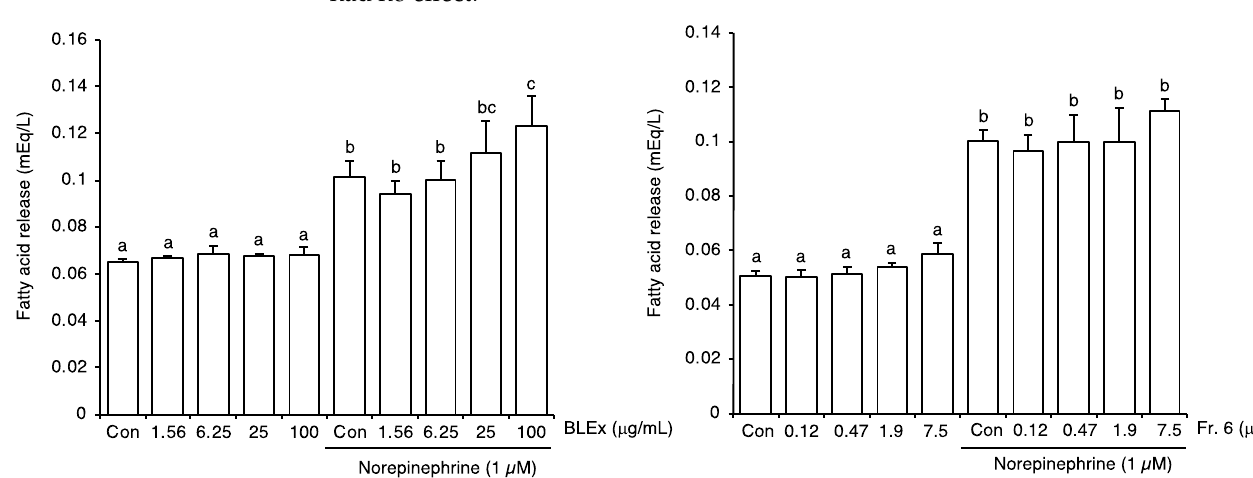
Figure 4. Effect of BLEx and Fr. 6 on the lipolysis of 3T3-L1 cells in matured adipocytes. Data are means ± SE for 3 independent experiments. Statistical analysis was performed using one-way analysis of variance (ANOVA) and post hoc tests (Tukey–Kramer multiple comparisons). Different alphabets indicate significant differences at p < 0.05. Matured adipocytes were stimulated with norepinephrine to promote lipolysis. Fatty acid release into the culture supernatant was measured as an index of lipolysis.